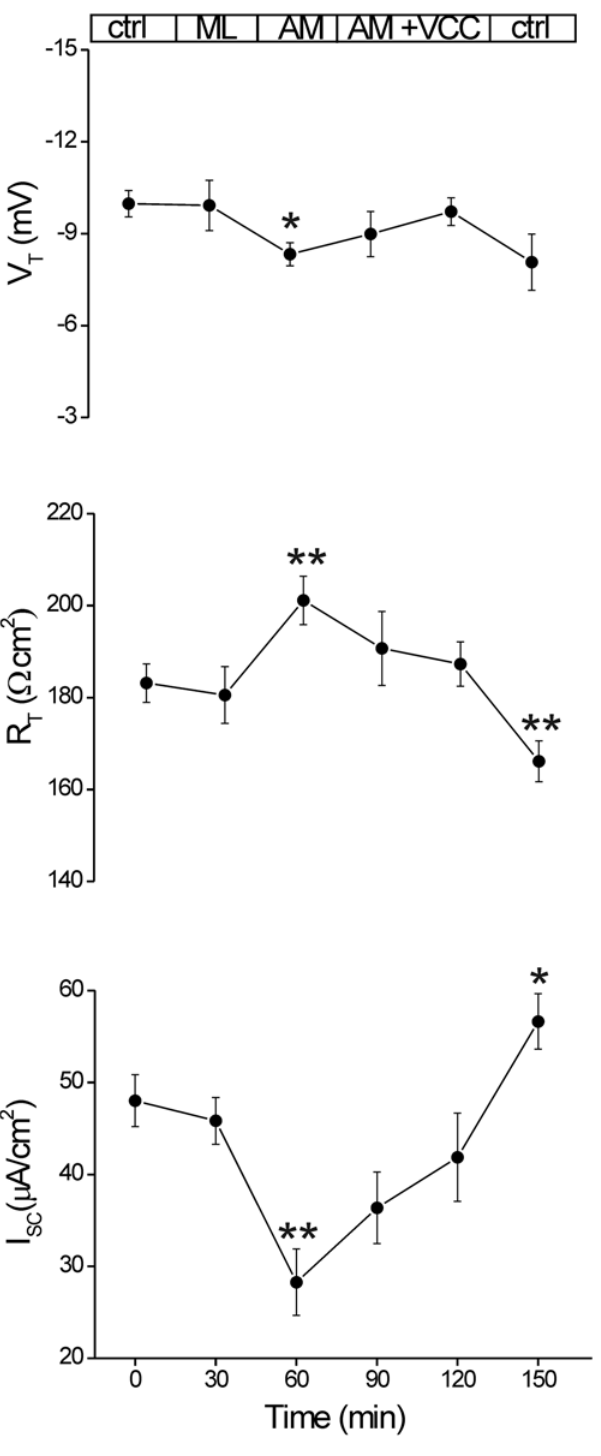
Figure 7. Effect of amiloride on VCC-induced Isc. Effect of VCC (1 nM) on Na + conductance was tested on amiloride (0.1 mM) pretreated human sigmoid colon (n=4; m=3). Electrical parameters were measured in the basal state (Ctrl), followed by incubation with mucosal amiloride (30 min), successive addition of VCC (60 min) and after removing the agonists (Ctrl). Significance was determined by Student’s t test for paired data of control (time=0) and treated; *, p , 0.05;**, p ,